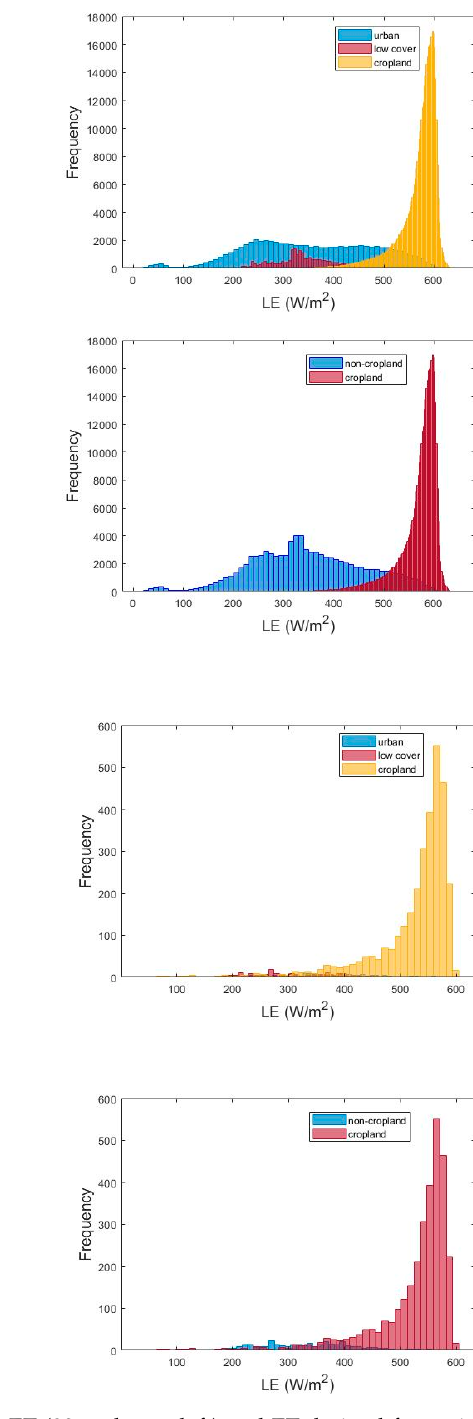
Figure 6. Comparison between ASTER derived ET (90 m, lower-left) and ET derived from aircraft image Track 10-2 (7.5 m, upper-left) maps and the associated histograms of the three main land cover types, alternatively combining urban and low canopy cover (semi-arid natural vegetation) under the broad land cover category of non-cropland.